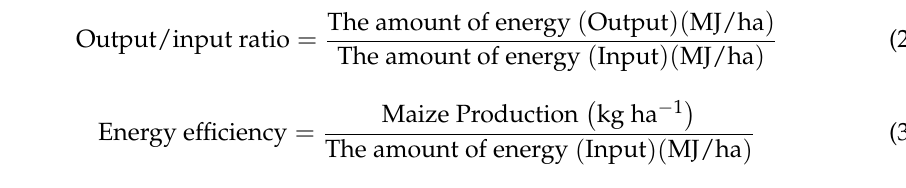
Table 1. Energy equivalents of inputs and outputs in agricultural